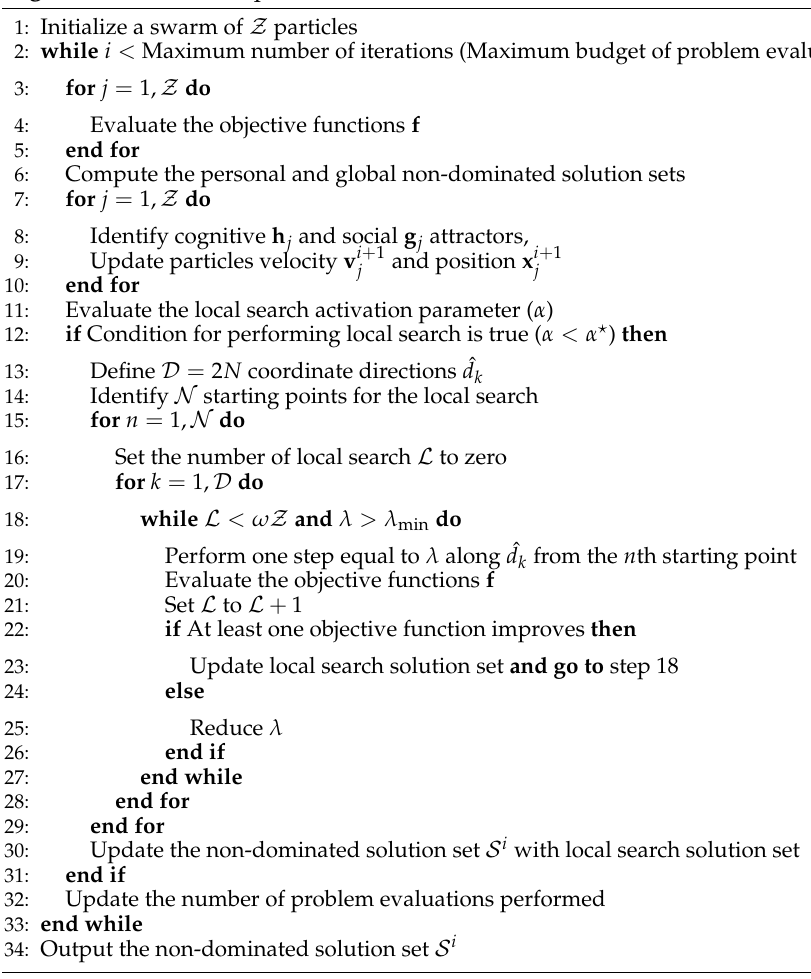
Algorithm 1 MODHA